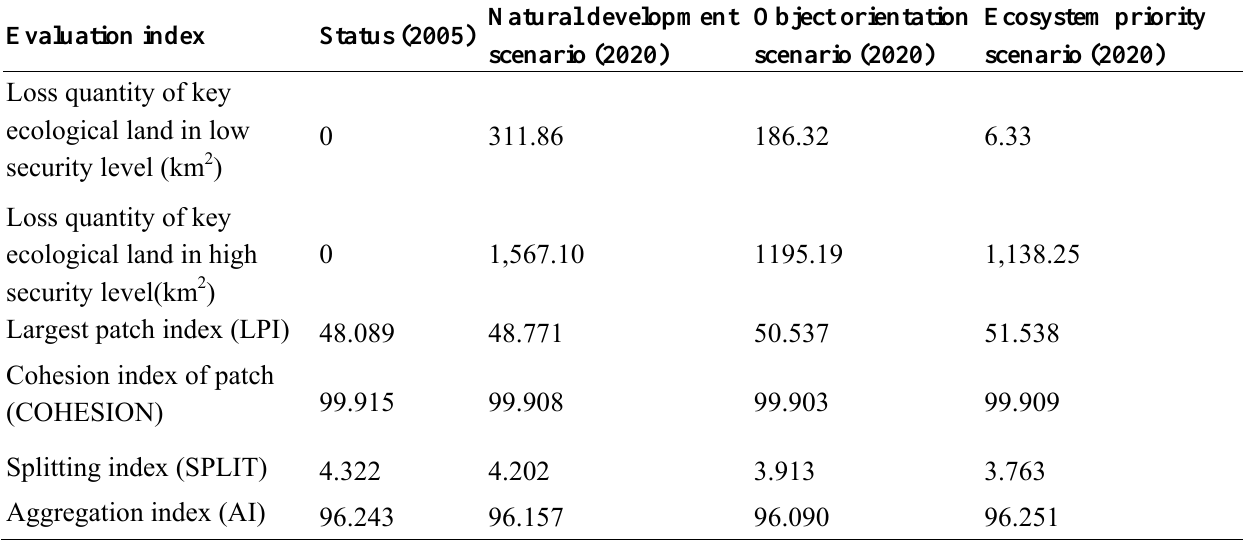
Table 5. Compare of protective effect of ecological land in different